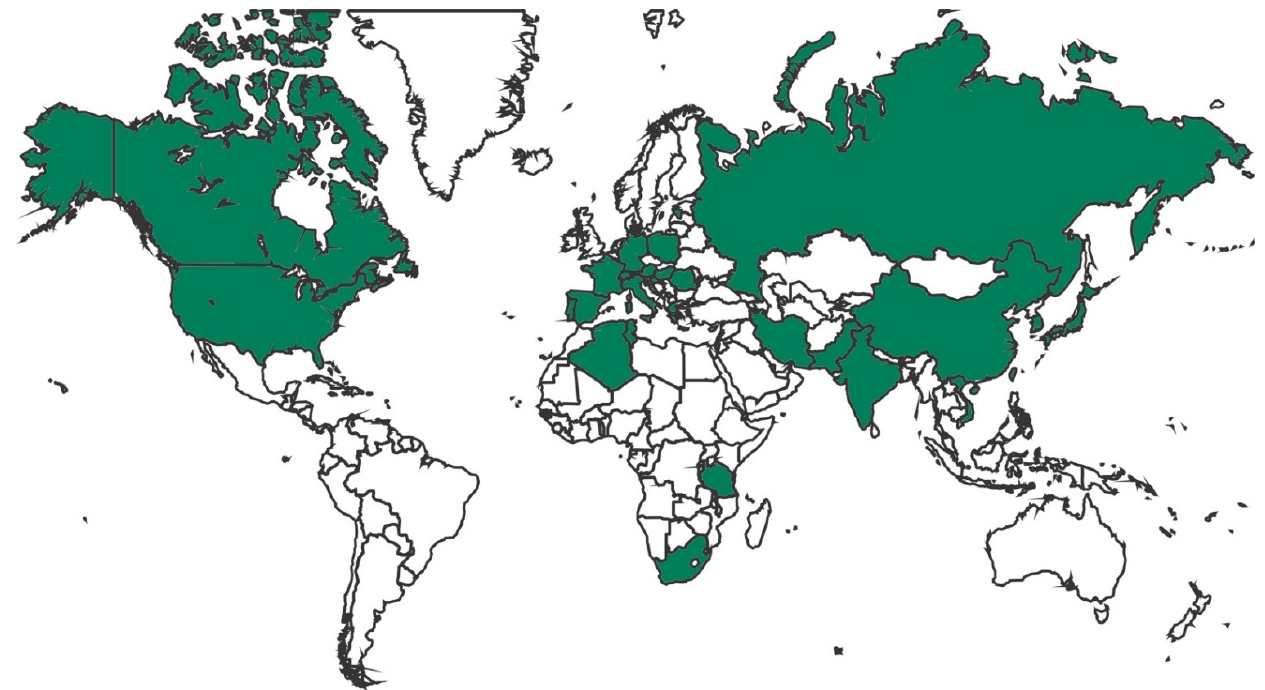
Figure 2. Geographic distribution of the authors who participated in Compounds during the past two years.